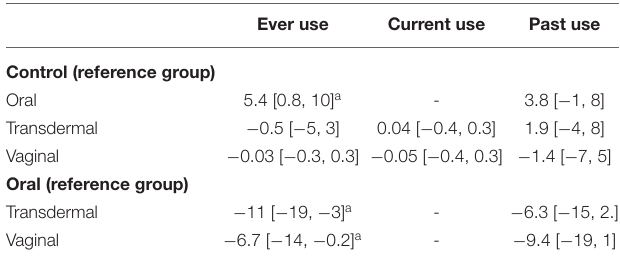
TABLE 4 | Multi-variate analysis of DBP by route of administration of hormone therapy type presented as beta coefficients, [95%